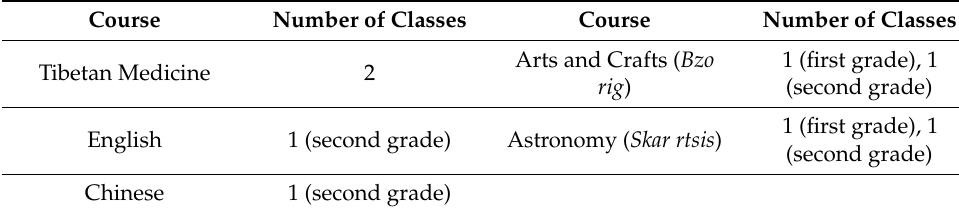
Table 9. Some courses not taught by Khenmos in